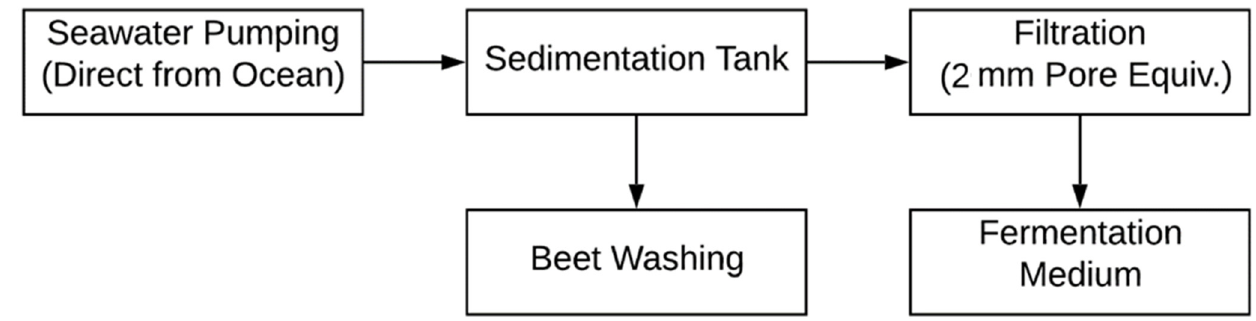
Figure 3. Sedimentation of sand achieves the purity required for sugar beet washing, while a second stage of treatment by filtration prepares the water for use in the fermentation medium. Filtration is granular, with an equivalent pore size of 2 mm to remove larger planktonic organisms.